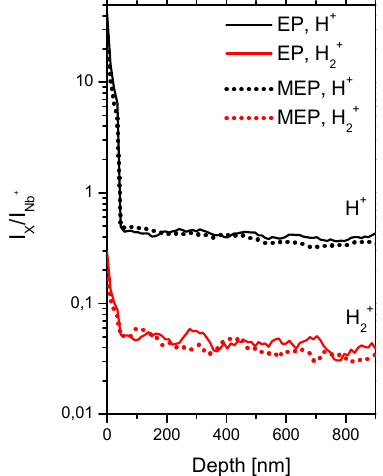
Figure 7. Dependence of ratio of secondary ion currents for positive hydrogen (H + and H 2+ ) to secondary ion currents of niobium on time of the ion etching. Values of ordinates presented in a smoothed form.